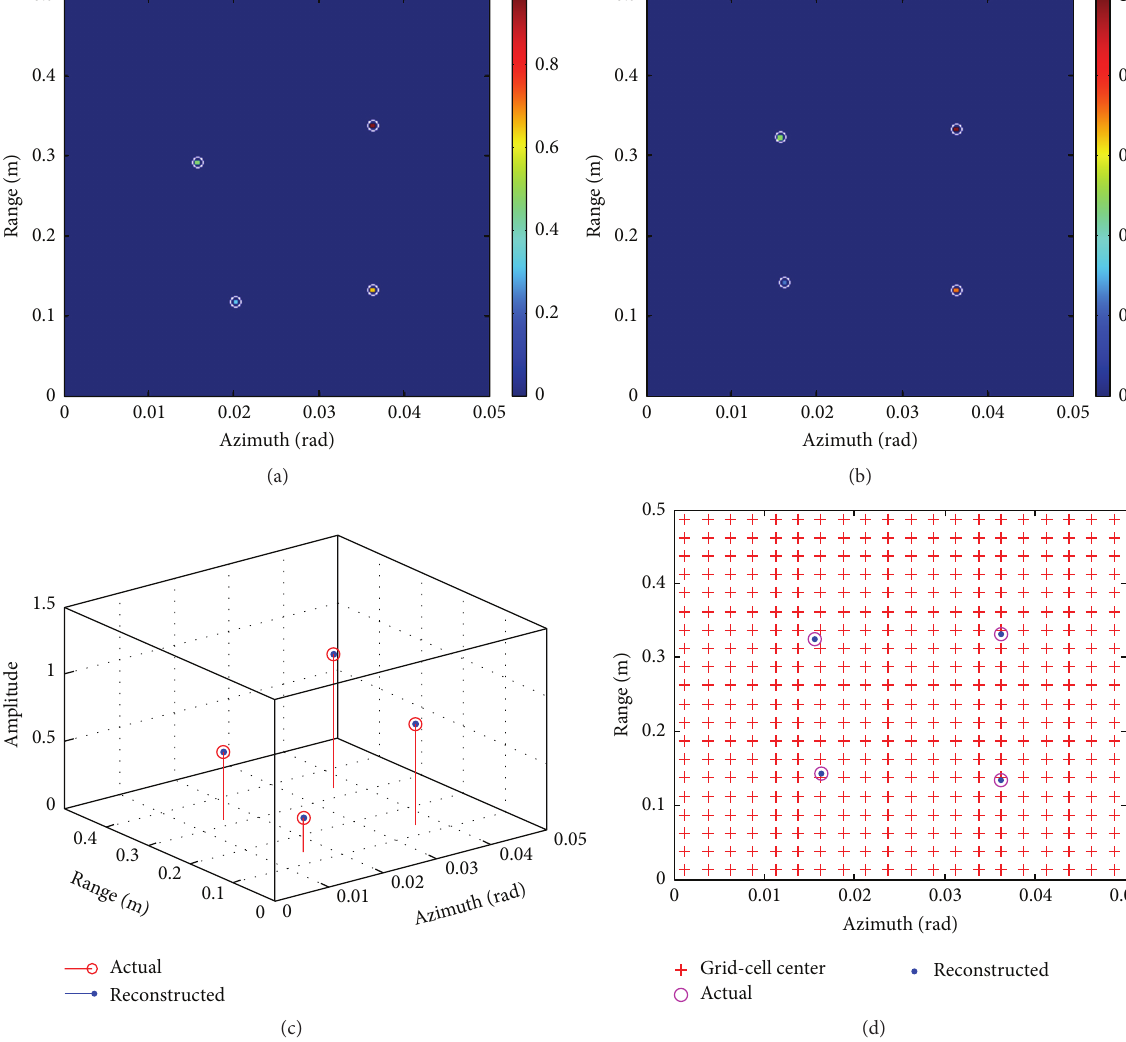
Figure 9: Off-grid RCI results. (a) Reconstructed image by OMP. (b) Reconstructed image by 2D BLOOMP. (c) Result of AIM algorithm. (d) Top view of